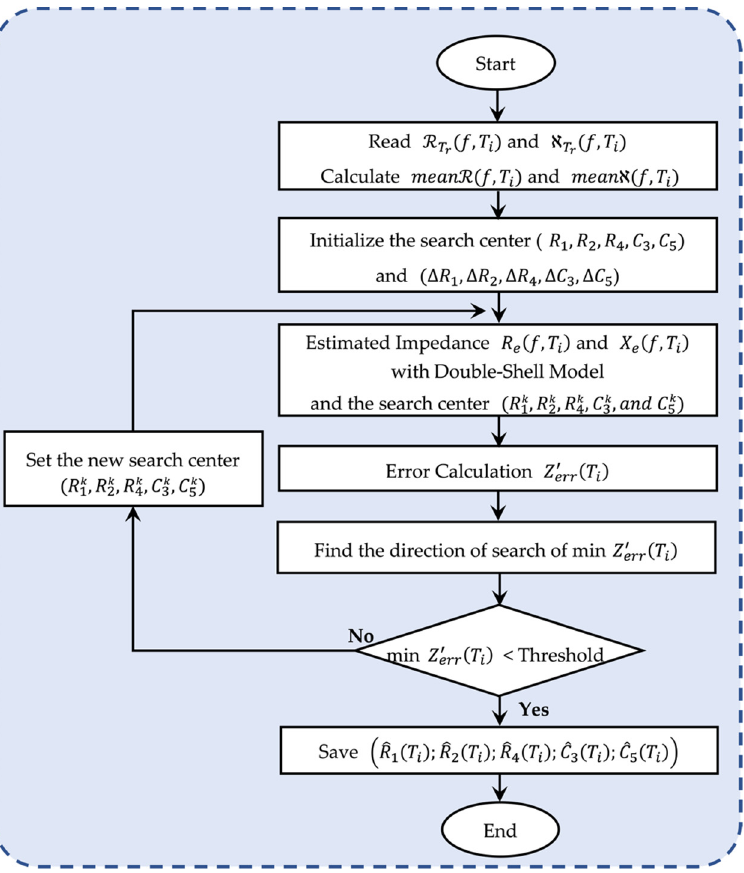
Figure 8. Flowchart of the proposed optimization algorithm to find the R-C values. The proposed flowchart is based on mathematical equations and interpolation. The results of the estimated R and C values ( ˆ R 1 ( T i ) , ˆ R 2 ( T i ) , ˆ R 4 ( T i ) , ˆ C 3 ( T i ) , ˆ C 5 ( T i ) ) as a function of time were used to understand the physiological changes in lettuce with the DSM. 𝑅 (cid:2869)(cid:3038) , 𝑅 (cid:2870)(cid:3038) , 𝑅 (cid:2872)(cid:3038) ,𝐶 (cid:2871)(cid:3038) ,𝑎𝑛𝑑 𝐶 (cid:2873)(cid:3038) are all search-point candi-dates. Z err ( T i ) is the impedance error as a function of